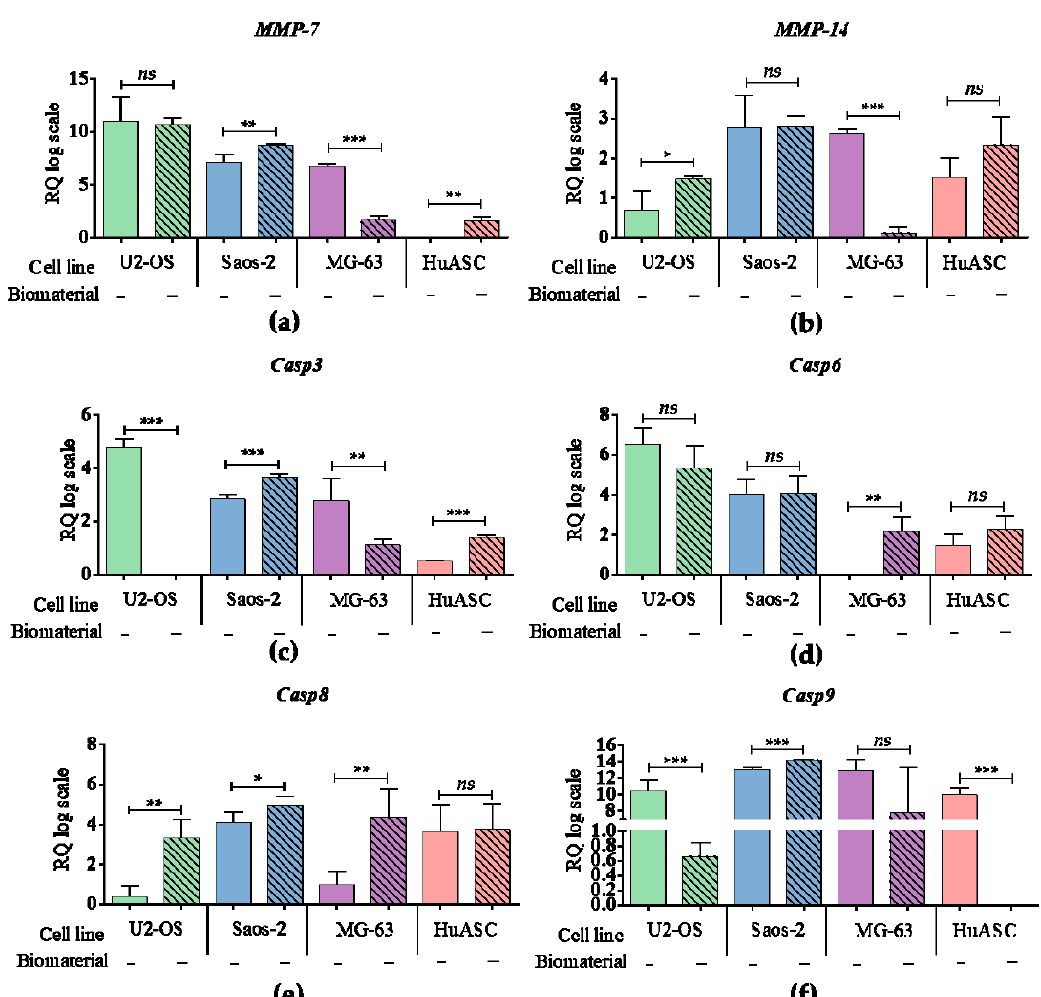
Figure 6. The analysis of mRNA level of genes associated with apoptosis and cell cycle. The examined targets were: ( a ) MMP-7, ( b ) MMP-14 and caspases: ( c ) caspase 3, ( d ) caspase 6, ( e ) caspase 8 and ( f ) caspase 9 . An asterisk marks a statistically significant di ff erences determined between tested culture circumstances (* p < 0.05, ** p < 0.01, *** p < 0.001). The expression of genes were measured using RT-qPCR technique, the relative quantification (RQ) was performed using 2 -DDCt method and scaling to the sample with highest expression of target gene. The results are expressed as mean ± SD.